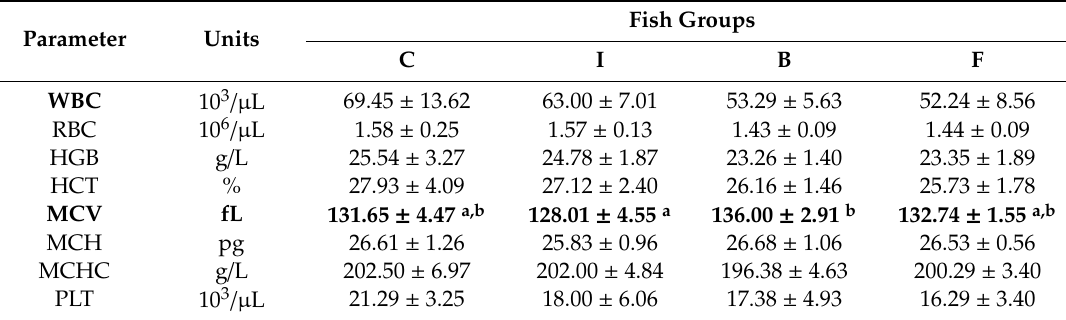
Di ff erent letters in the table point statistical significance.